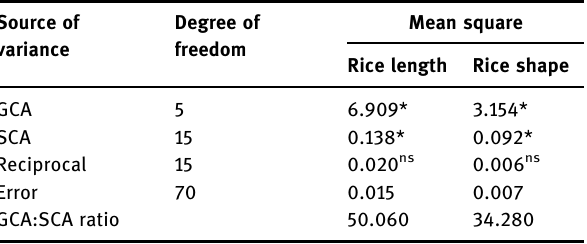
Table 5: Analysis of variance of combining ability and GCA:SCA ratio of length and shape of rice Source of